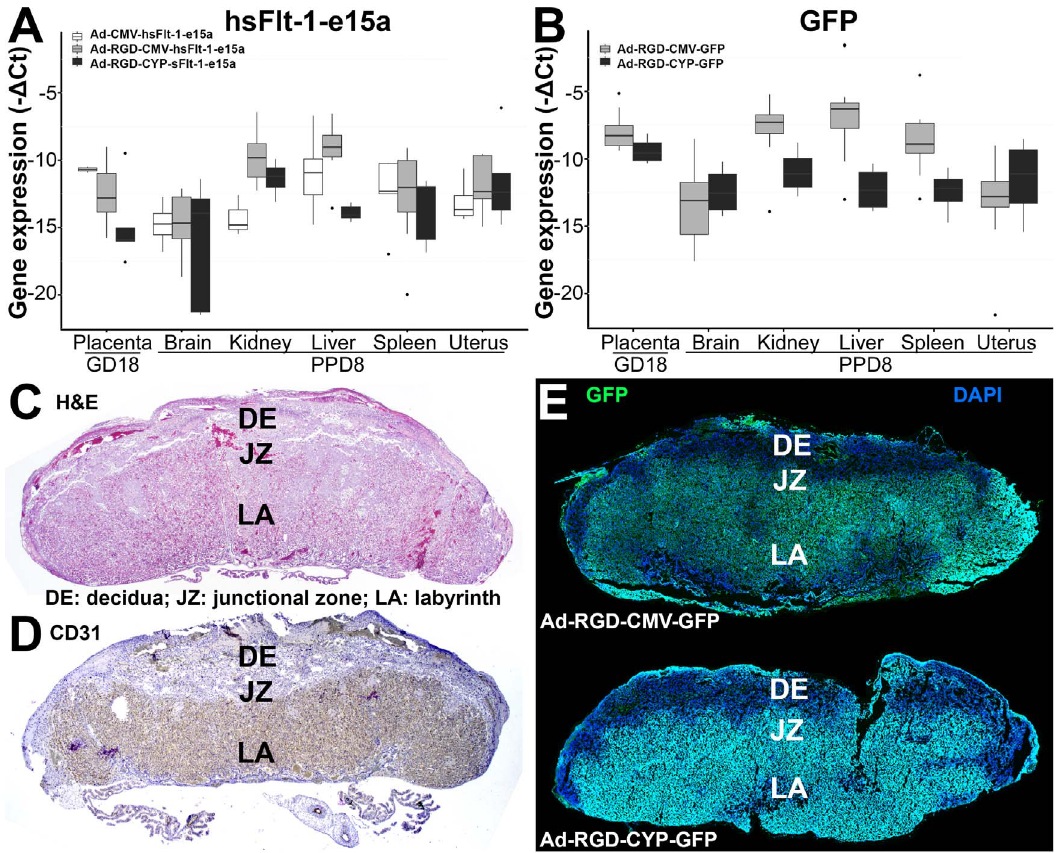
Figure 4. Profiling of hsFlt-1-e15a and GFP expression. ( A ) Boxplots show the expression profile of the transgenic hsFlt-1-e15a mRNA overexpressed by three different adenoviral vectors (Ad-CMV-hsFlt-1-e15a; Ad-RGD-CMV-hsFlt-1-e15a; Ad-RGD-CYP-hsFlt-1-e15a) in placentas harvested on gestational day (GD) 18 and in tissues harvested on postpartum day (PPD) 8. ( B ) Boxplots show the expression profile of GFP mRNA overexpressed by two different vectors (Ad-RGD-CMV-GFP; Ad-RGD-CYP-GFP) in placentas harvested on GD18 and in tissues harvested on PPD8. ( C ) Control placenta, H&E staining, 20x magnification. ( D ) Control placenta, anti-CD31 immunostaining, 20x magnification. The CD31 immunopositivity of the labyrinthine vessels are clearly seen. ( E, F ) Confocal microscopic images of placentas from GFP-treated mice. The placental expression of adenoviral GFP was the strongest in the labyrinth in both the Ad-RGD-CMV-GFP and Ad-RGD-CYP-GFP treated groups.